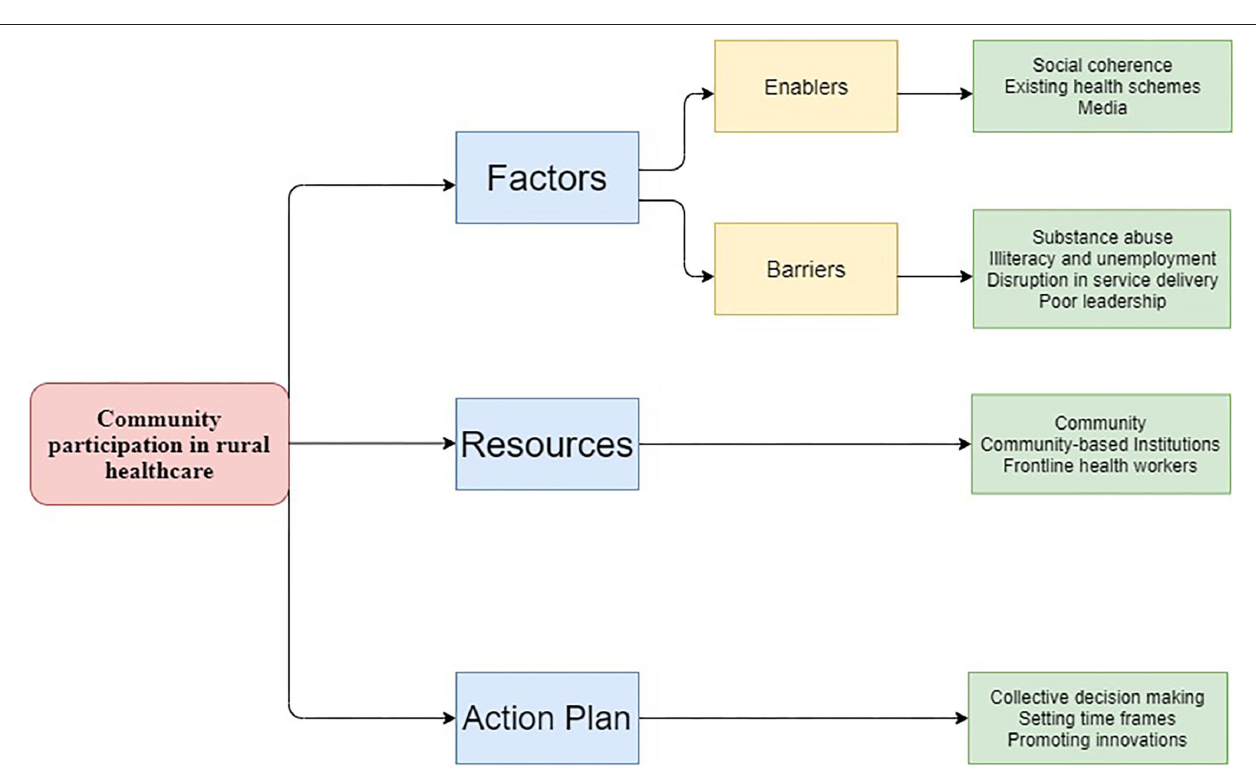
FIGURE 6 | Community participation